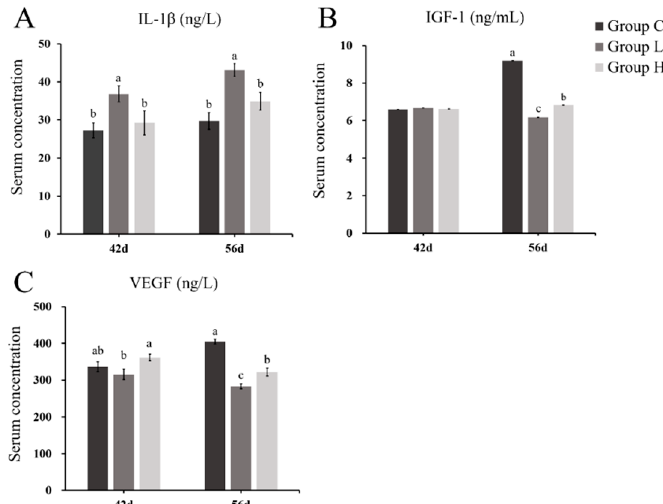
Figure 3. The changes of serum indicants related to extracellular matrix (ECM) homeostasis. ( A ) The changes of serum catabolic cytokines interleukin-1 β (IL-1 β ) in different groups. ( B ) and ( C ) The changes of serum anabolic cytokines insulin-like growth factor 1 (IGF-1) and vascular endothelial growth factor (VEGF) in different groups. Superscripts with different letters indicate significant differences ( p < 0.05).